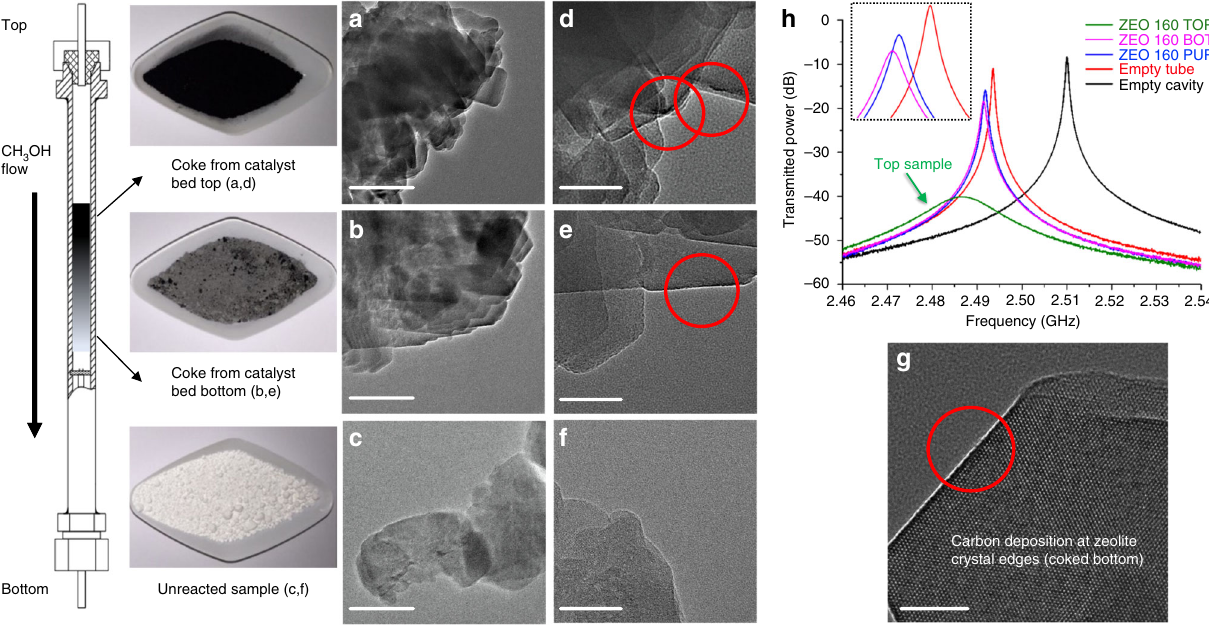
Fig. 2 Coke depositions of ZEO 160 sample along the catalyst bed shown with their TEM pictures and microwave plots. a – c 200 nm vision transmission electron microscopy (TEM) images of coked top, coked bottom, and un-reacted samples. Overall 50 nm vision TEM images of coked top ( d ), coked bottom ( e ) and un-reacted ( f ) samples. Bulky powders and a schematic representation of the coke depositions in color gradient along the methanol fl ow route in the employed fi xed bed reactor are shown on the left . g Ampli fi ed 20 nm TEM image implies carbon accumulation at the zeolite crystal edges. h Captured microwave plots induced by different samples (ZEO 160 group) and conditions. Catalyst unloading started from the reactor top by removing the top nut carefully. Black , deeply-coked samples ( top ) were collected fi rstly, until the lightly coked, gray color samples ( bottom ) emerged. The word BOT in h is an abbreviation for bottom. Scale bar : a – c 200 nm; d – f 50 nm and g 20